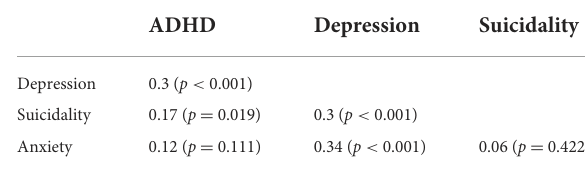
TABLE 2 ADHD, GAD, depression, suicidal behavior and their